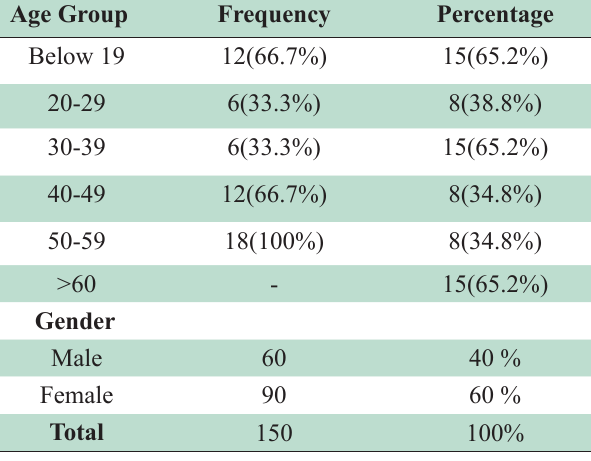
Table-I: Age Distribution of patients